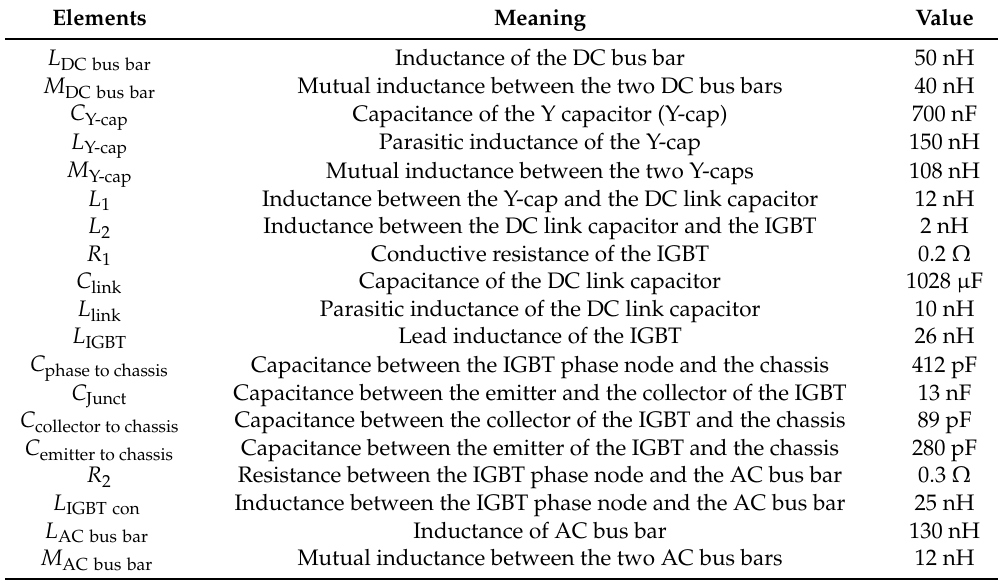
Table 1. Values of components within equivalent